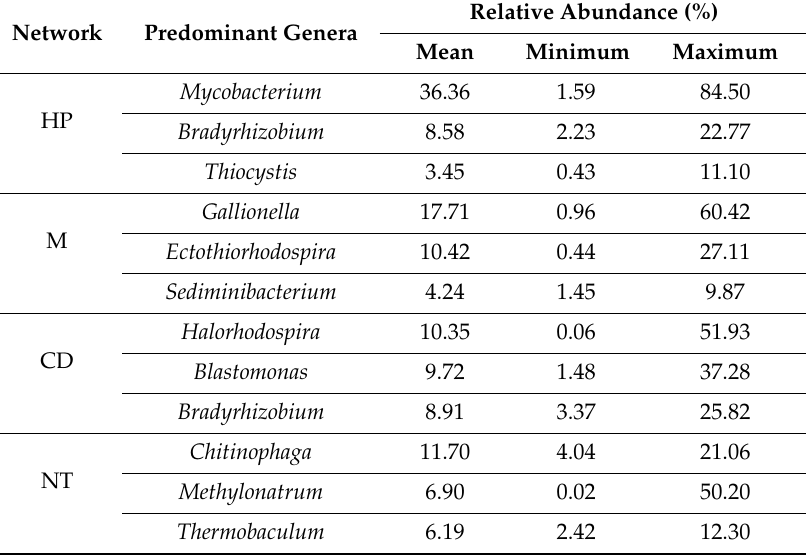
Figure 4. Distribution of genera in hot water samples (cut off 2%), clustering for hot water network (pools). Genera with relative abundance ≤2% are included in "other". HP: network with hydrogen peroxide, M: network with monochloramine, CD: network with chlorine dioxide, and NT: not chemically treated network. Table 3. The three predominant genera for each hot water network. HP: network with hydrogen peroxide, M: network with monochloramine, CD: network with chlorine dioxide and NT: not chemically treated